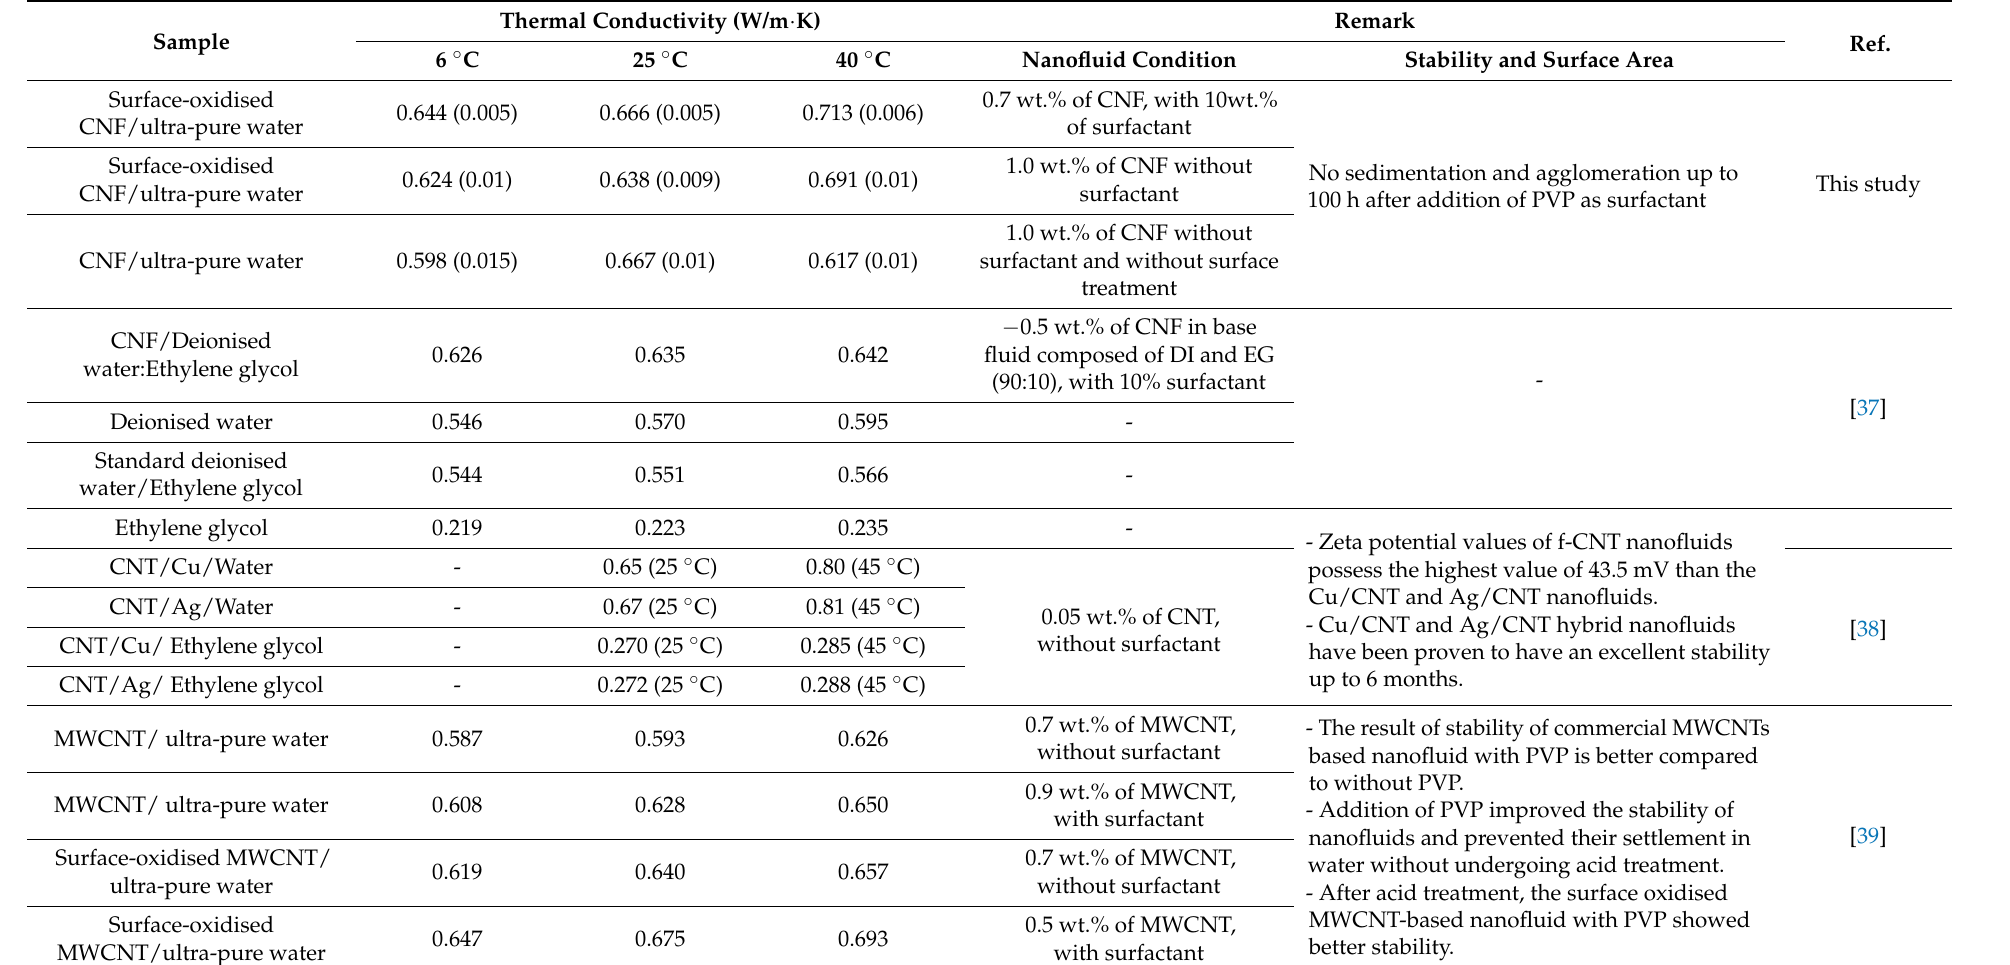
Table 9. Summary of comparison for thermal conductivity studies for CNF/water with and without surfactant, cooling liquids, and selected nanomaterials in